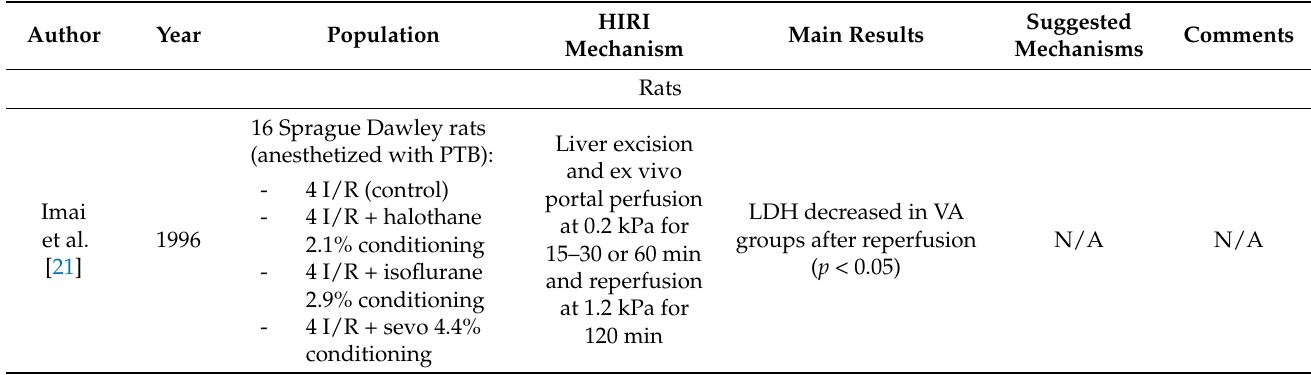
Table 1. Experimental